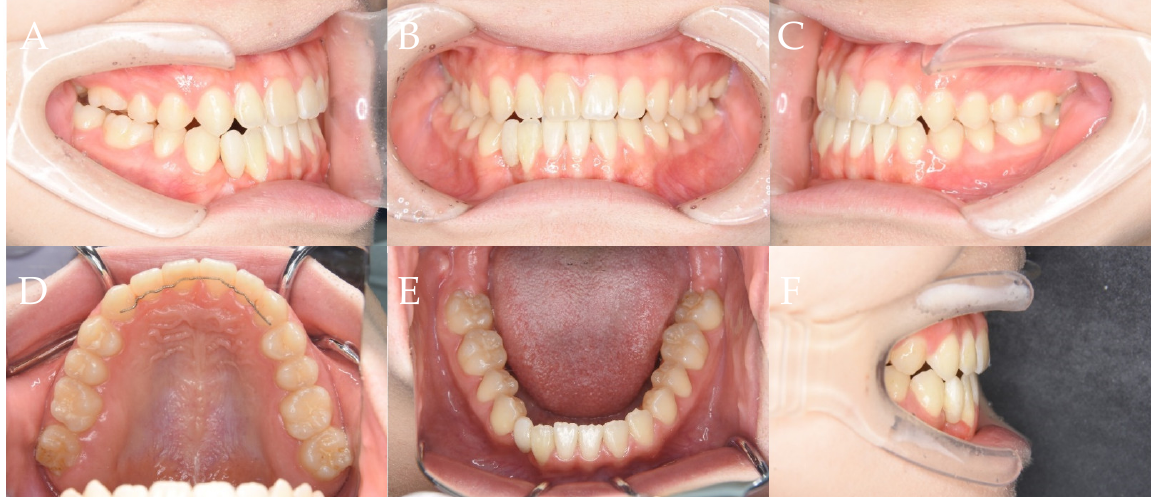
Figure 10. Post-treatment panoramic radiograph.